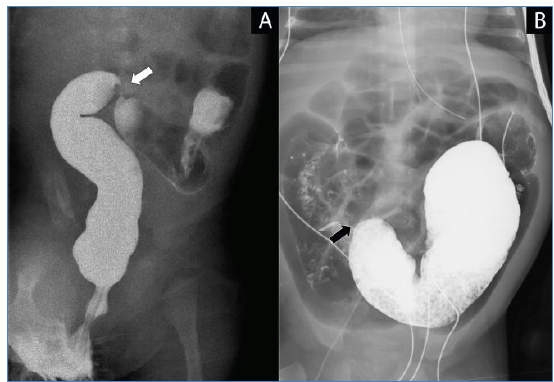
Figure 1: Panel A contrast enema with sigmoid colon stricture (white arrow) 4 weeks after onset of NEC; Panel B follow-through with distal ileum stricture (black arrow) 4 weeks after onset of NEC.